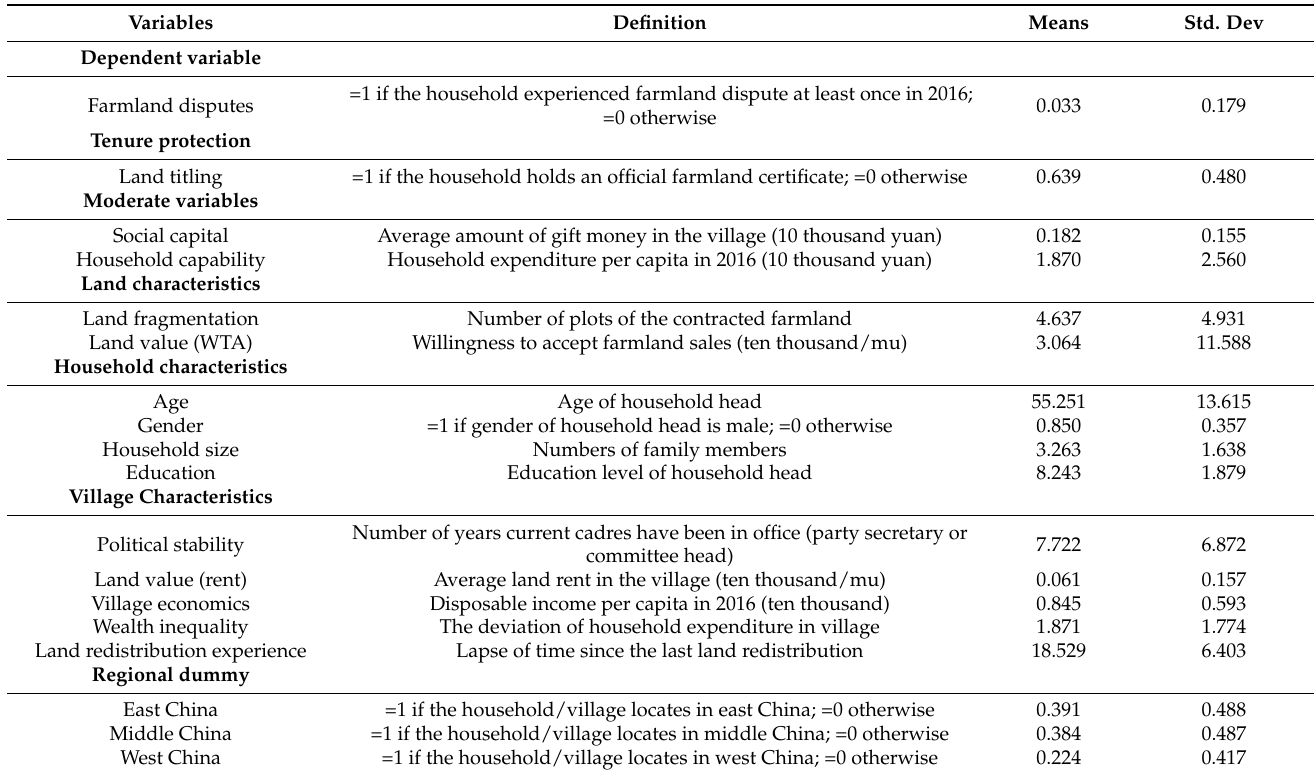
Table 1. Definitions and descriptions of variables.